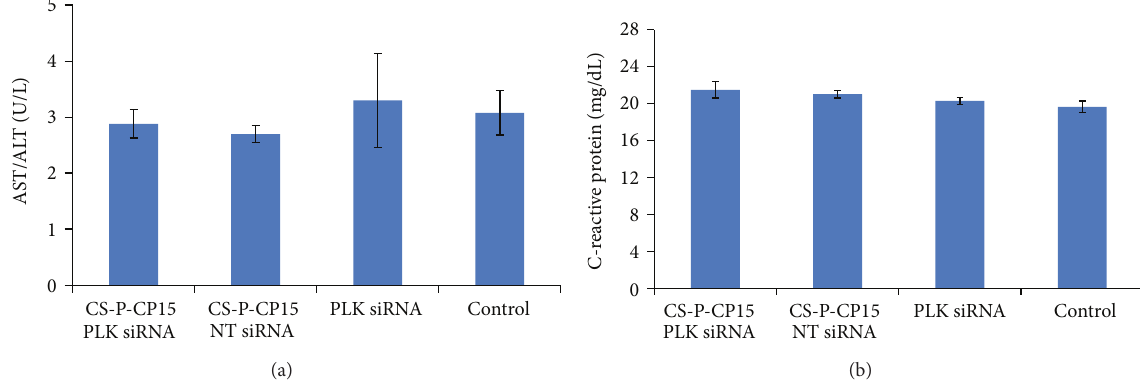
Figure 7: Serum analysis was performed as a safety test for comparing the (a) CRP and (b) ALT, AST levels among different treatment groups. The results indicate no significant difference between the treatment group (CS-PEG-CP15) containing siRNA against PLK1 gene with mock transfections and untreated controls. This concludes that the treatment formulation had no deleterious effect in terms of toxicity and immunological reactions on the animals. The graph shows a representative result of 𝑛 = 5 in each group, mean ± SE, with no statistical significance according to Tuckey’s post hoc analysis, when compared with other